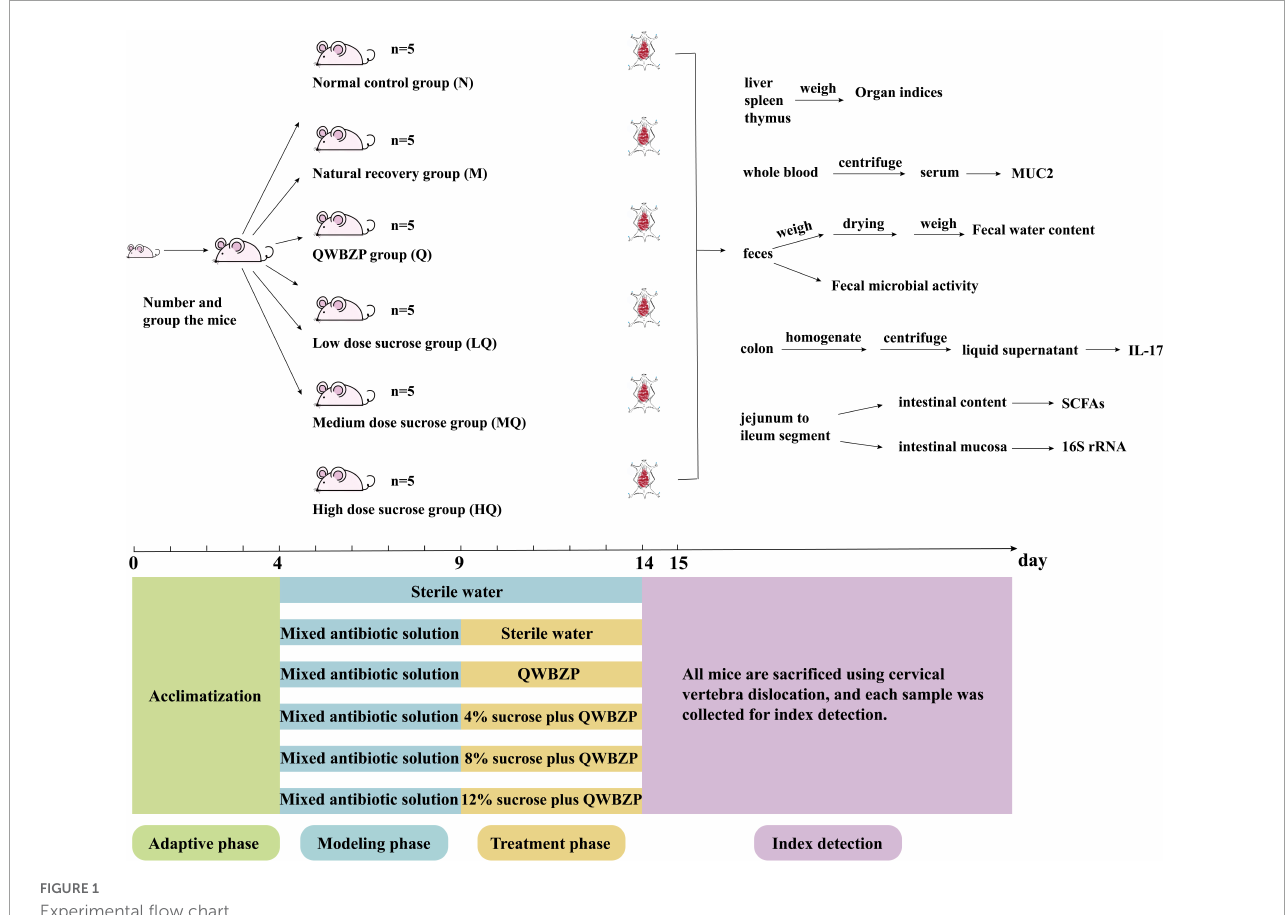
FIGURE1 Experimental flow